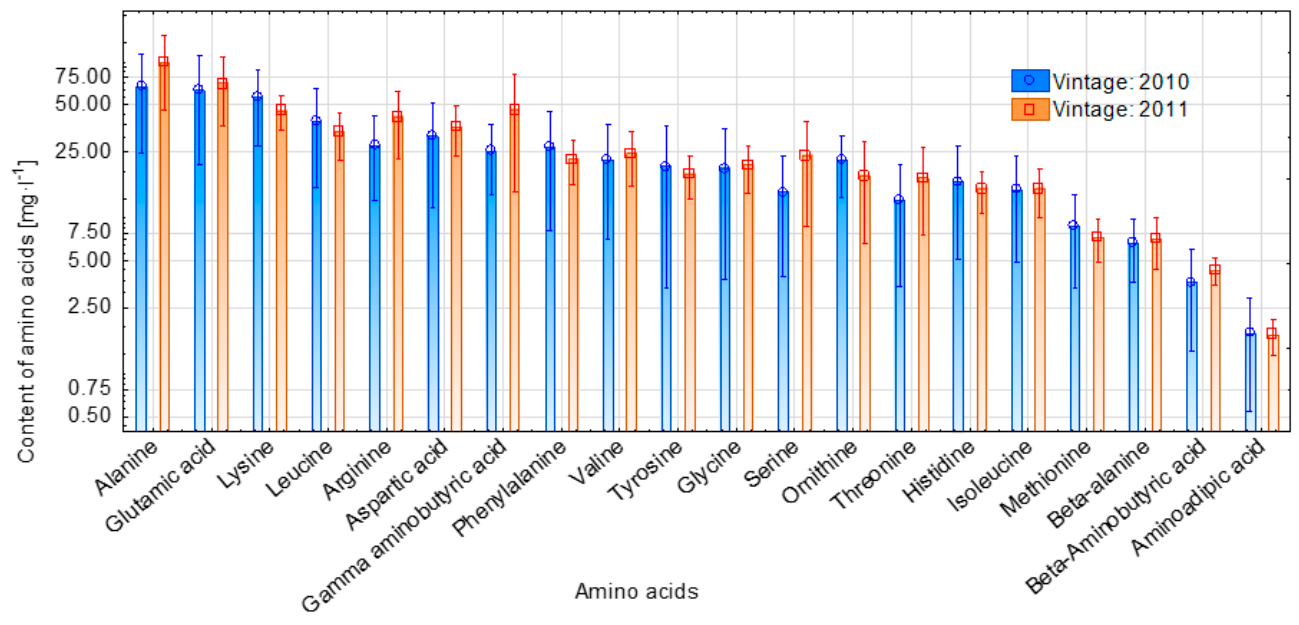
Figure 5. Comparison of average amino-acid content by year.